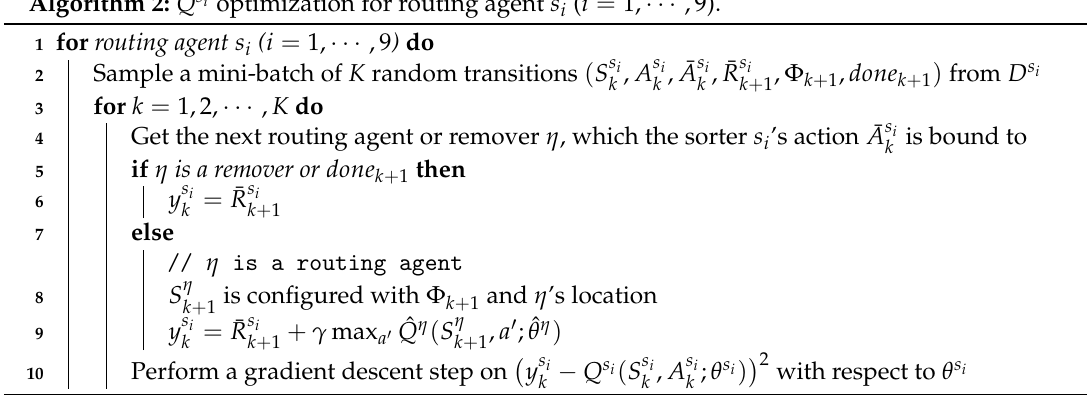
Algorithm 2: Q s i optimization for routing agent s i ( i = 1,